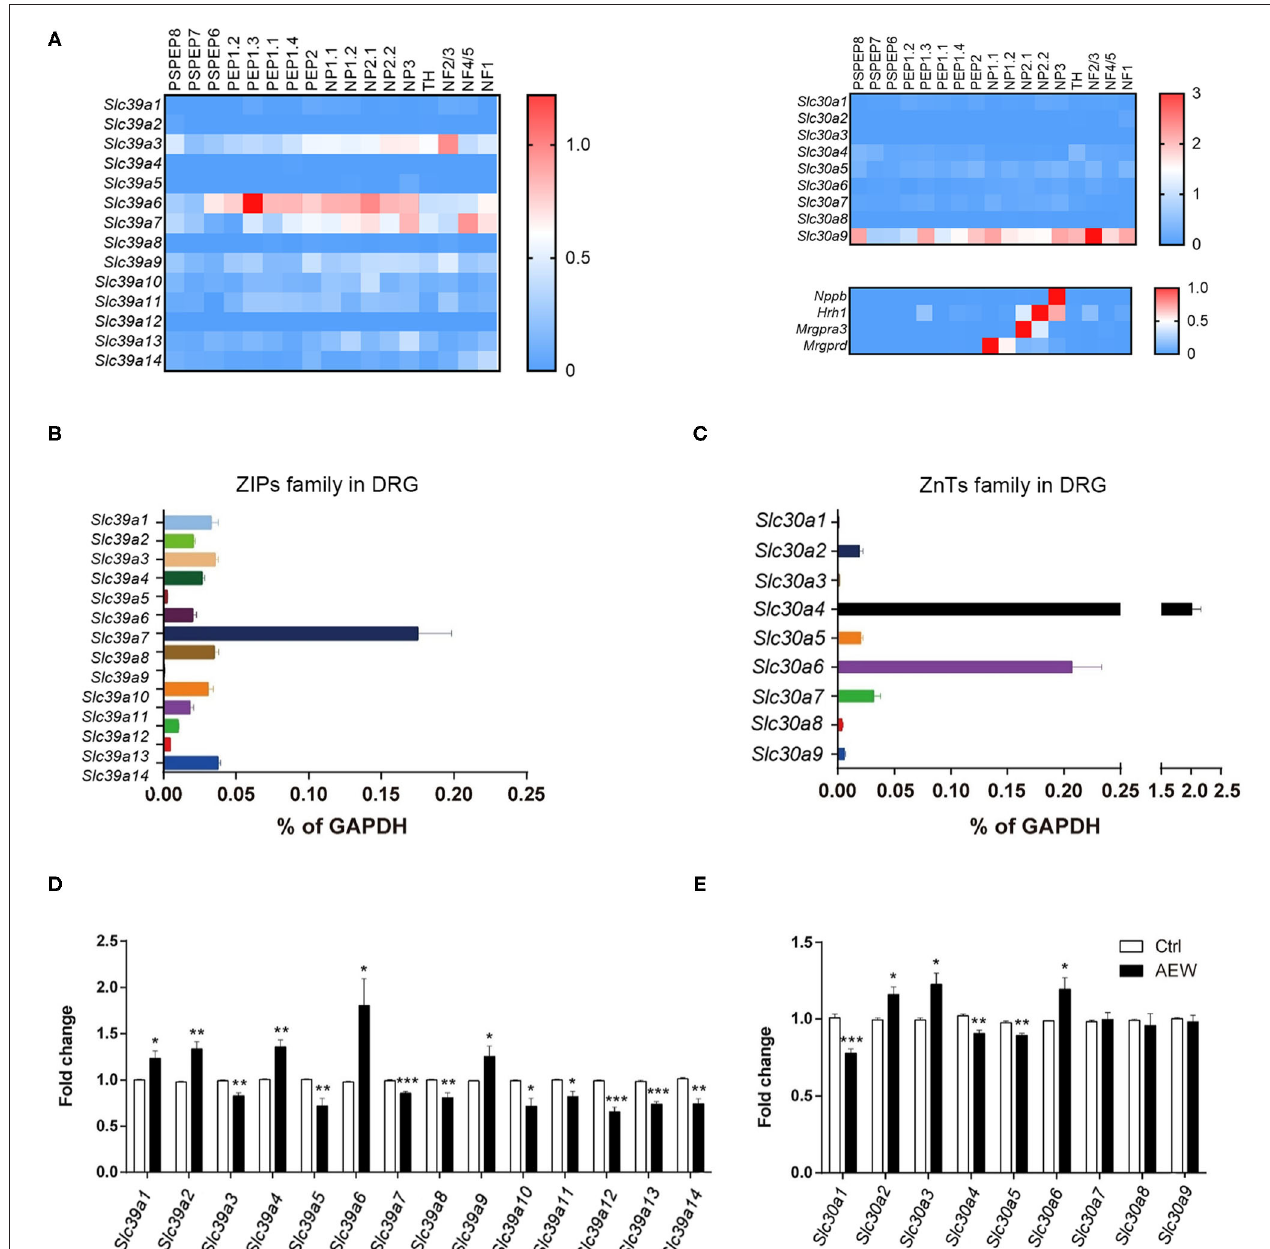
FIGURE 7 | The expression of ZIPs/ Slc39as and ZnTs/ Slc30as in the DRG of dry skin induced chronic itch model. (A) The gene expression of ZIPs and ZnTs family and itch marker in the DRG neuron of mouse based on previous published single cell RNA-seq database. (B,C) The mRNA expression levels of (B) Slc39as and (C) Slc30as in the DRG of WT mice. (D,E) The mRNA expression levels of (D) Slc39as and (E) Slc30as in the DRG of dry skin induced chronic itch model (* P < 0.05, ** P < 0.01, *** P < 0.001 vs. Ctrl, unpaired Student’s t -test; n = 5 per group). All data are expressed by means ± SEM. Ctrl, control; n.s., not significant.